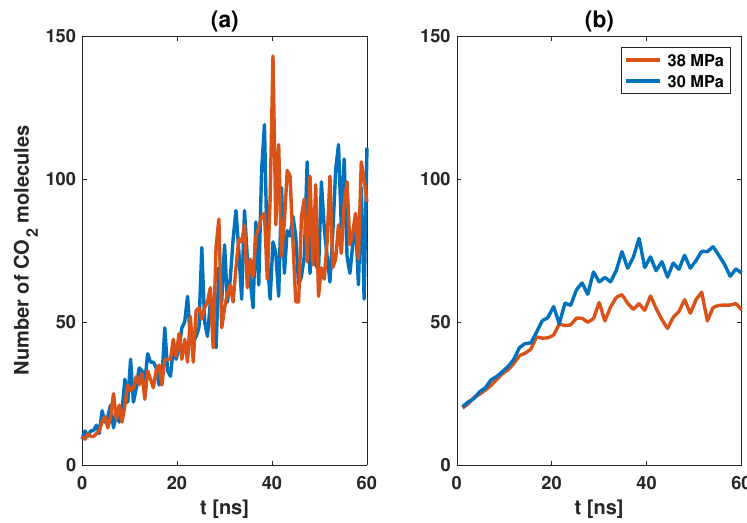
Figure 8. ( a ) Number of CO 2 molecules in the biggest bubble. ( b ) Number of CO 2 molecules exchanged between the bubble and the surroundings. We collected all data over a time interval of 1.2